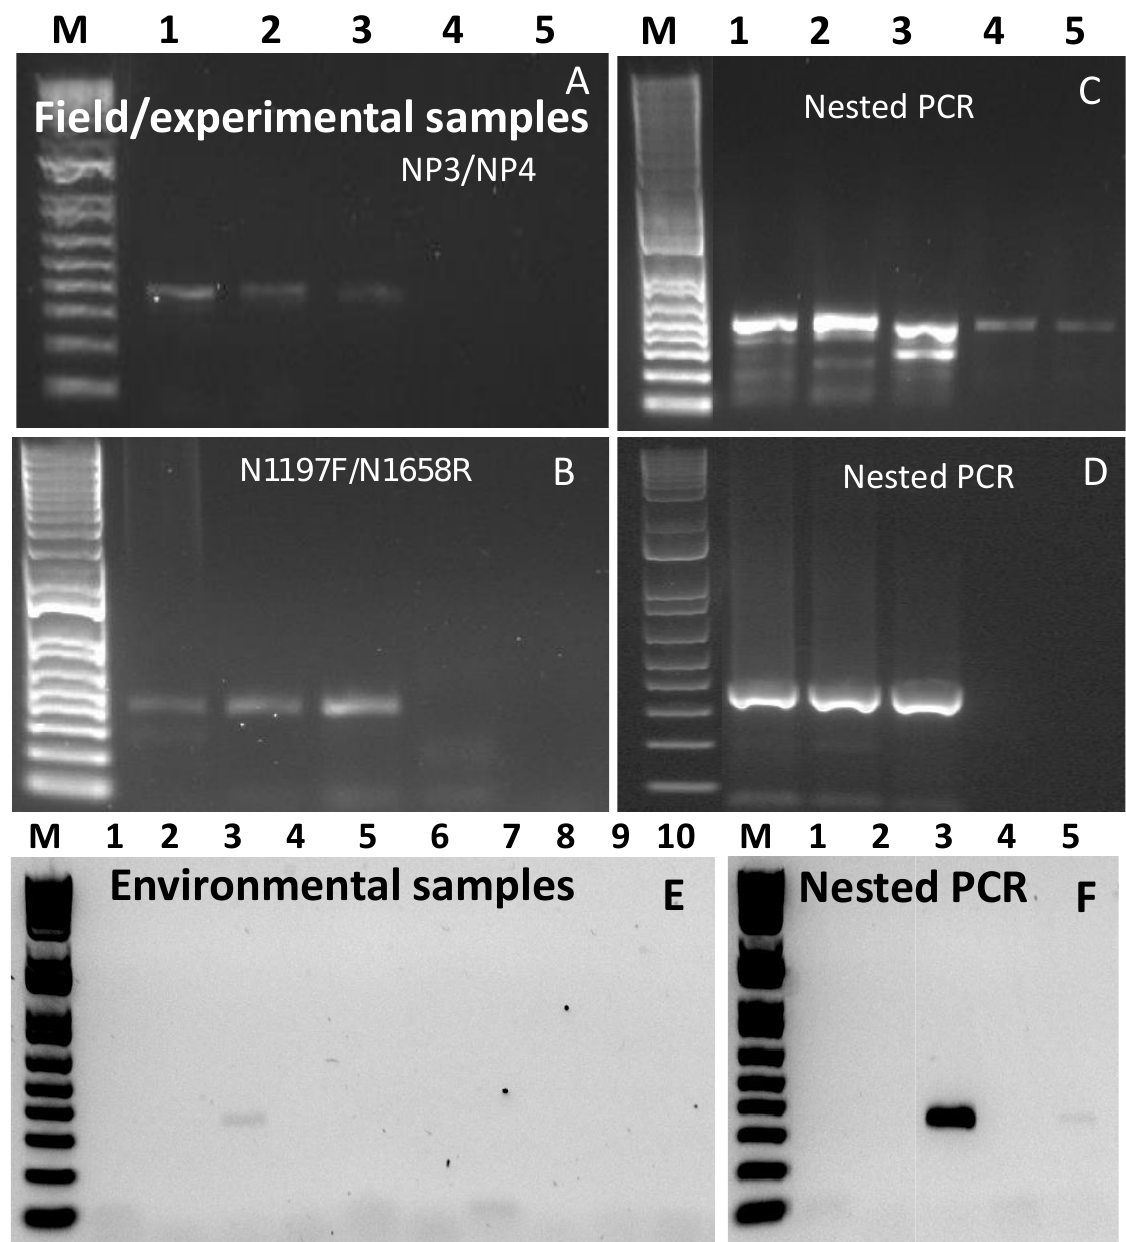
Figure 6. Gel images of PCR products using field/experimental (correspond to samples 17–21 in Table 1) samples ( A – D ) and environmental (correspond to samples 22–26 in Table 1) samples ( E , F ). ( A ): PCR products obtained from first round of PCR using primer pair NP3/NP4, ( B ): PCR products obtained from first round of PCR using primer pair N1197F/N1658R, ( C ): nested PCR products using primer pair NP3/NP4, ( D ): nested PCR products using primer pair NP3/NP4 when template DNA was purified, ( E ): PCR products obtained from first round of PCR using primer pair NP3/NP4 (lanes 1–5) and N1197F/N1658R (lanes 6–10) of environmental samples from Nepal (correspond to samples 22–26 in Table 1), ( F ): nested PCR products of environmental samples using primer pair NP3/NP4. M: 1 kb plus marker DNA.